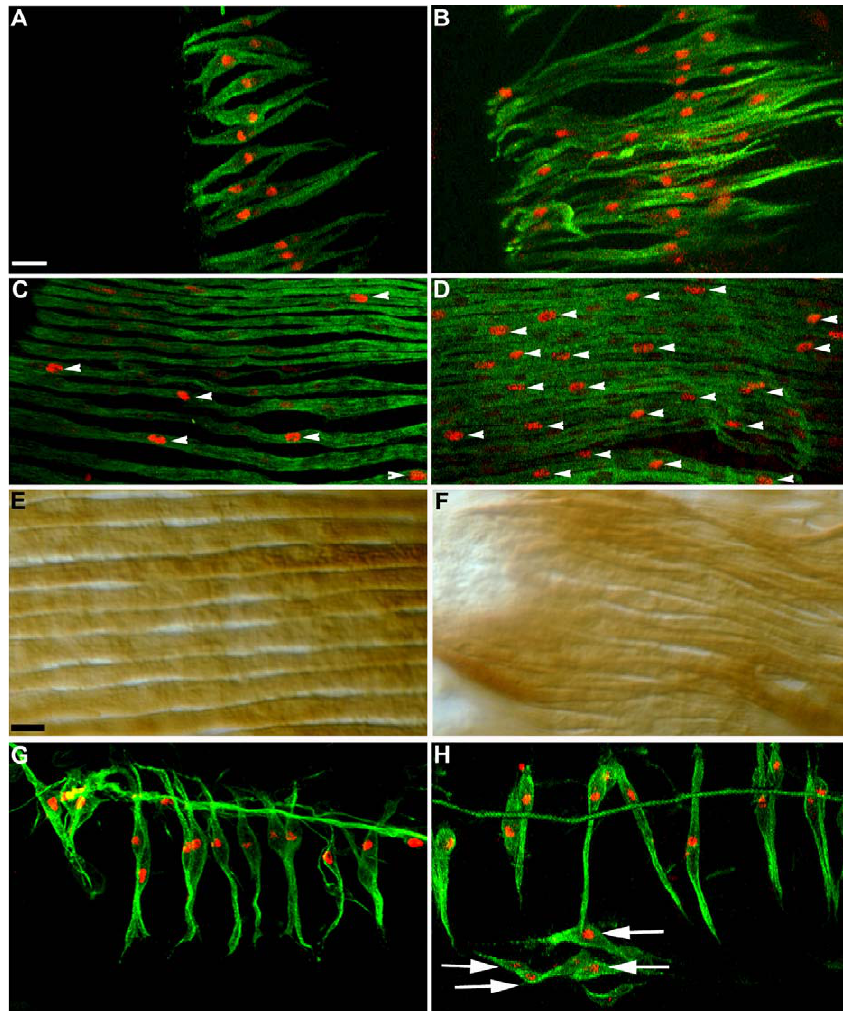
Figure 4. Increase in Founder and Fibre Number upon Activation of Htl Signalling in Myoblasts (A and B) Pupae 28 h APF (grown at 29 8 C) double-labelled with anti- b -galactosidase (red) and 22C10 (green). (A) duf-lacZ pupa showing wild-type pattern of founders in a section of lateral hemi-segment. The number of founders seen in this section is 13. (B) 1151/duf-lacZ; UAS- k htl/ þ pupa showing excess number of lateral founders (26) in an equivalent region. (C and D) Pupae 42 h APF (at 29 8 C) double-labelled with anti- b -galactosidase (red) and anti-MHC (green). (C) duf-lacZ pupa showing the wild-type lateral myofibres, each having one high duf-lacZ -expressing nucleus (white arrowheads). (D) 1151/duf-lacZ; UAS- k htl/ þ pupa showing extra number of lateral fibres. White arrowheads indicate high duf-lacZ -expressing nuclei within these fibres. For many fibres, in both (C) and (D), the high duf-lacZ - expressing nucleus is not within the field of view. (E and F) DIC images of Canton-S (E) and 1151/ þ ; UAS- k htl/ þ pupae labelled with anti-MHC at 42 h APF. In contrast to the neat array of wild-type muscle fibres (E), myofibres in UAS- k htl mis-expressed pupa are heaped in bundles (F). (G) Normal pattern of dorsal founders in duf-lacZ pupa at 28 hAPF (at 29 8 C). (H) Founder pattern in the dorsal hemi-segment of a 1151/duf-lacZ; UAS- k htl/ þ pupa similarly aged to that in (G). White arrows indicate the extra founder cells that have appeared below the normal set of fibres. Anterior is at top; dorsal midline is at left. Scale bar ¼ 20 l m (A–D, G, and H), 13 l m (E and F). DOI: